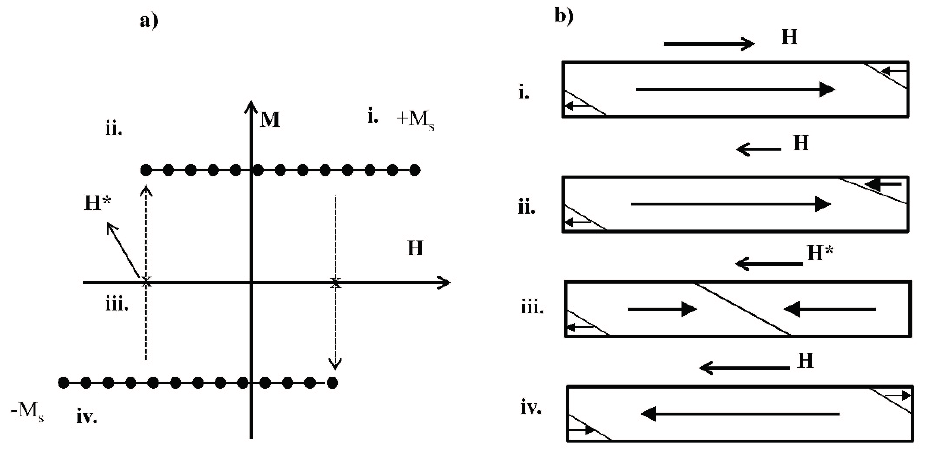
Figure 2. ( a ) A schematic representation of the domain structure at the inner core during different stages of the magnetization process; ( b ) The corresponding states in the hysteresis